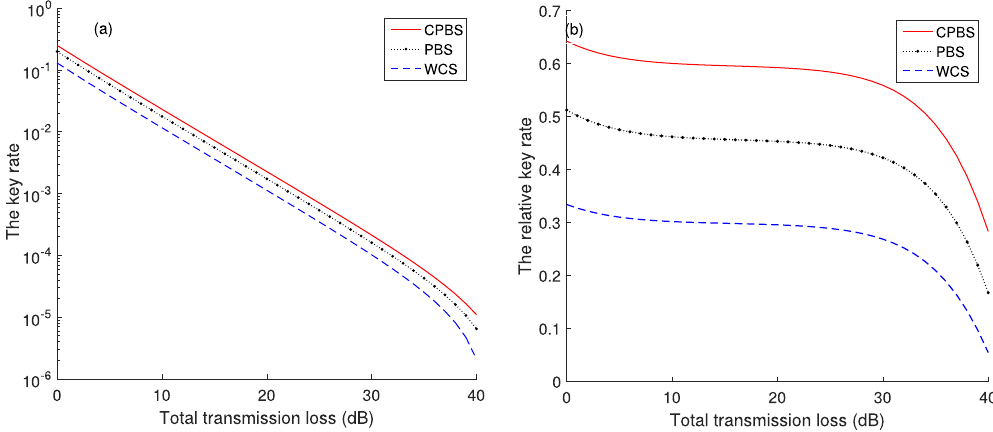
Figure 6. ( a ) Key rates of decoy state BB84 protocol with different sources: cascaded photon-blockade source (CPBS), the photon-blockade source without a cascade (PBS) 19 and WCS. ( b ) The relative value of the key rates between chosen sources and the perfect single-photon source (PSPS).